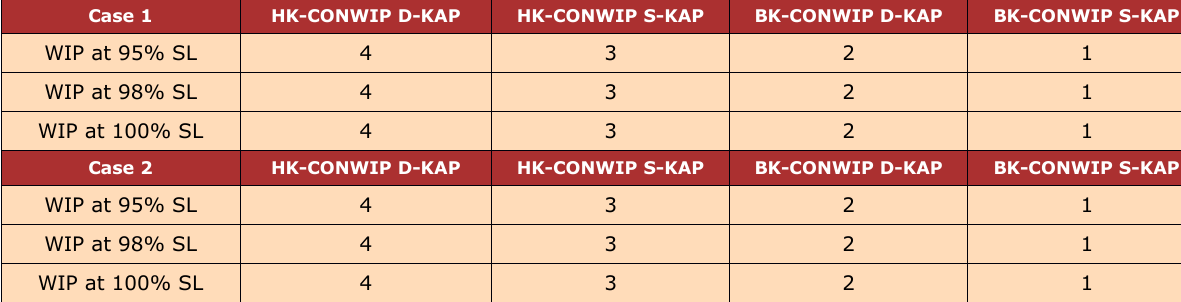
Table 11. All-pairwise comparison ranking